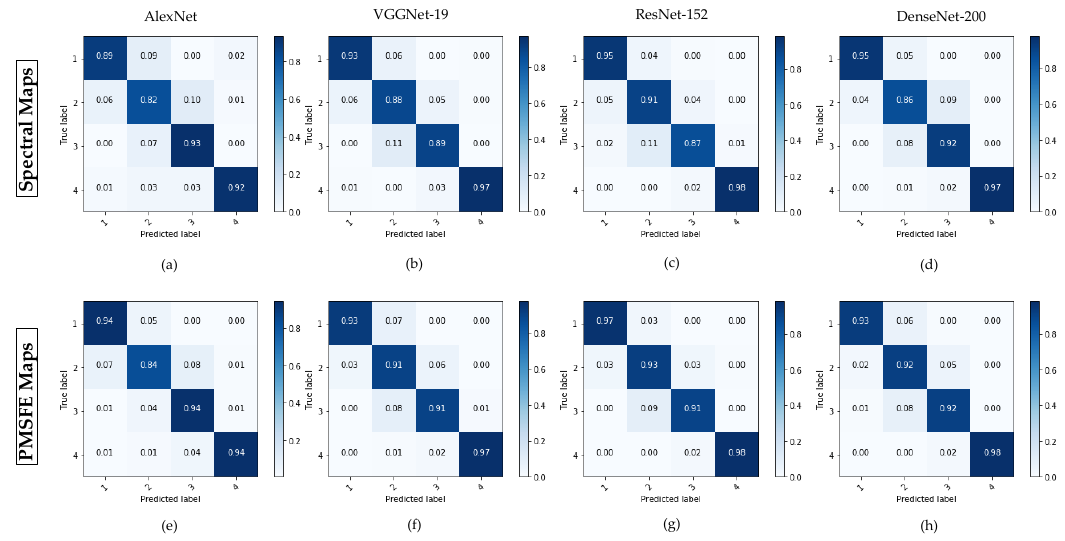
Figure 10. The confusion matrix of spectral maps and PMSFE maps. ( a ) The confusion matrix of spectral maps in AlexNet. ( b ) The confusion matrix of spectral maps in VGGNet-19. ( c ) The confusion matrix of spectral maps in ResNet-152. ( d ) The confusion matrix of spectral maps in DenseNet-200. ( e ) The confusion matrix of PMSFE maps in AlexNet. ( f ) The confusion matrix of PMSFE maps in VGGNet-19. ( g ) The confusion matrix of PMSFE maps in ResNet-152. ( h ) The confusion matrix of PMSFE maps in DenseNet-200.